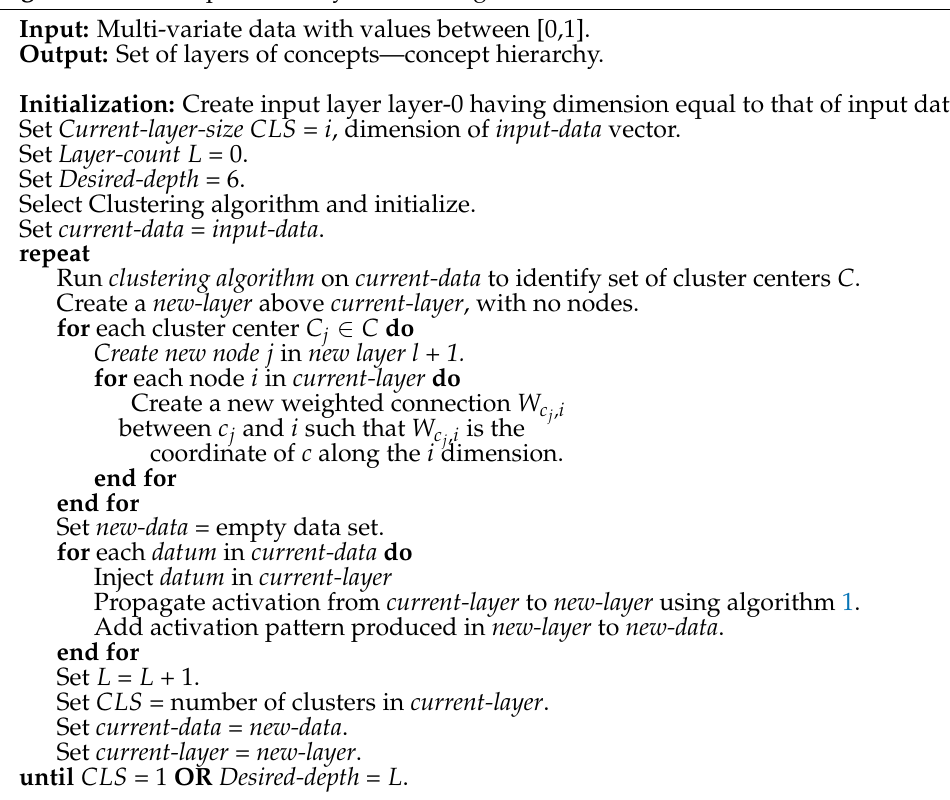
Algorithm 2 Concept Hierarchy Creation